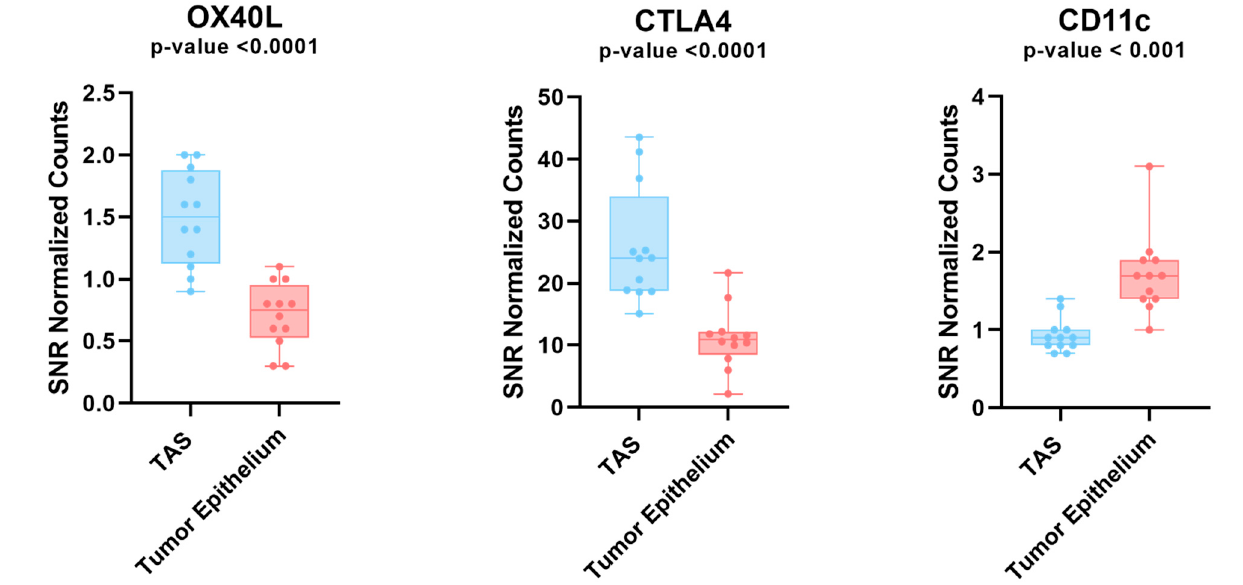
Figure 3. Protein expression analysis in tumor and TAS tissue across 4 prostate cancer patients. Box plot depicting the protein expression levels of OX40L, CTLA4, and CD11c. These genes all had significant differences between tumor and TAS. OX40L and CTLA4 were the only two proteins that were upregulated in tumor adjacent stroma compared to tumor. Each dot represents an ROI. TAS = tumor-adjacent stroma; ROI = region of interest.